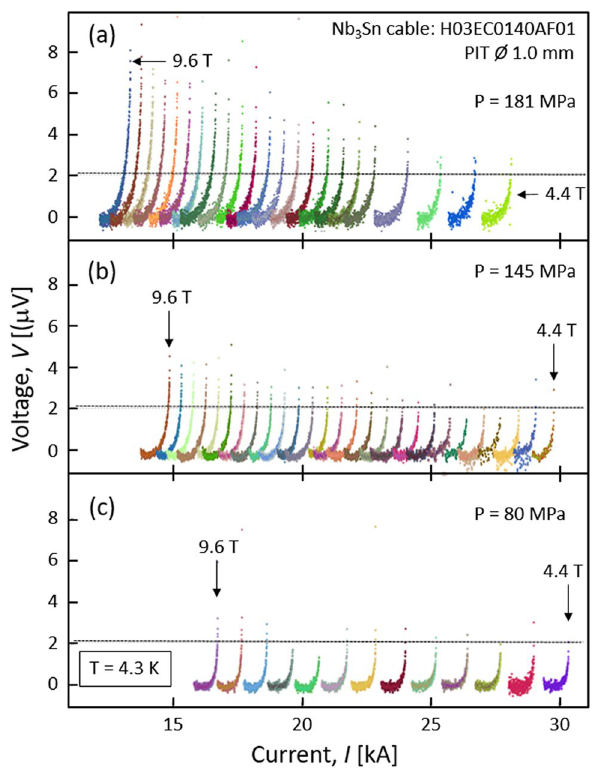
Figure 1. V–I characteristics of the PIT cable at 4.3 K collected at different background fields, at the following pressure: ( a ) 181 MPa (Test #9); ( b ) 145 MPa (Test #6); ( c ) 80 MPa (Test #1). The voltage corresponding to the chosen electric field criterion, E c = 3 × 10 –2 μV/cm, is represented by a horizontal dashed line (2.085 μV; voltage tap pair: FM).